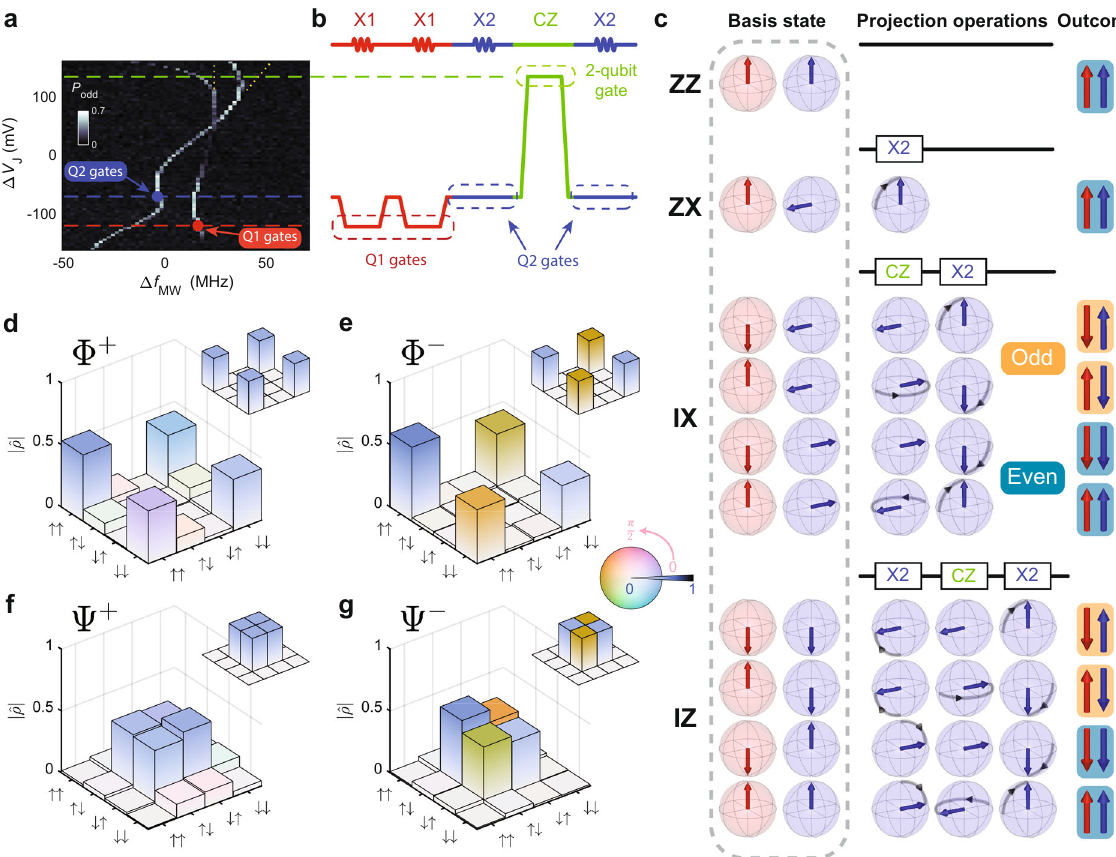
Fig. 3 Bell state tomography. a Adiabatic inversion probability of both qubits as a function of detuned microwave frequency Δ f MW , where the carrier (cid:1) (cid:3) (cid:1) frequency is chosen to be the single-qubit operation frequency for Q2 and J gate voltage Δ V J , with qubits initialized in the ## state. Horizontal dashed lines represent J gate voltages applied for various single-qubit and two-qubit gates. Yellow dotted lines are a guide indicating the other resonance frequencies that would be observed at Δ V J > 100 mV if the spins were initialized randomly. b Schematic of an example microwave and voltage pulse (cid:1) (cid:3) (cid:1) by performing two π sequence for state tomography. It initializes the qubits as "# ×1 pulses (all calibration is performed for π pulses, such that a high- 2 2 fi delity π pulse is obtained by composing it out of two π gates, each starting and fi nishing at a common voltage Δ V J = − 70 mV, which is shown as a blue 2 dashed line in a ), then perform IZ projection operation, by converting the parity readout into single-qubit readout via a CNOT gate 4 . Horizontal lines align with Δ V J from a . c Example qubit states and operations required to obtain projections along the indicated axes. The fi rst, two columns of Bloch spheres represent the eigenstates of Q1 (red) and Q2 (blue) before state tomography, whereas the rest illustrates the logic gate operations required for state tomography, before parity readout. For IX and IZ, all possible initial eigenstates are displayed, with parity results shown on the last column. d – g Quantum- j i þ ## j i ffiffi p . The height of the bars represents the absolute state tomography of Bell states d Φ þ ¼ "" 2 value of density matrix elements, whereas complex phase information is encoded in the colour map. Inset: bar graph of the ideal density matrix of the corresponding Bell state. The measured fi delities of each Bell state are (87.1 ± 2.8)%, (90.3 ± 3.0)%, (90.3 ± 2.4)%, and (90.2 ± 2.9)%, from d to g ,